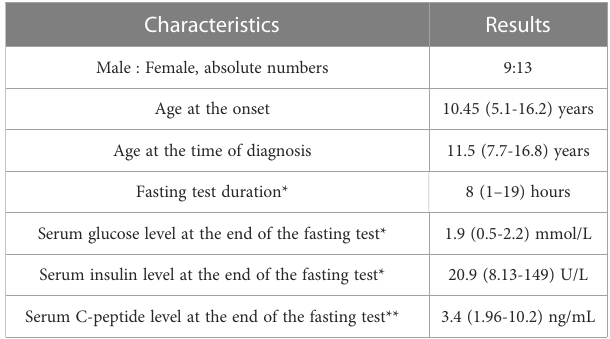
Figure 1 represents results of different imaging technics used for the evaluation of pancreatic lesions in our cohort of patients. Five children (23%) had multiple pancreatic lesions. The 30 lesions were found equally in all parts of the pancreas (tail; n=11, head; n=10, body; n=9).